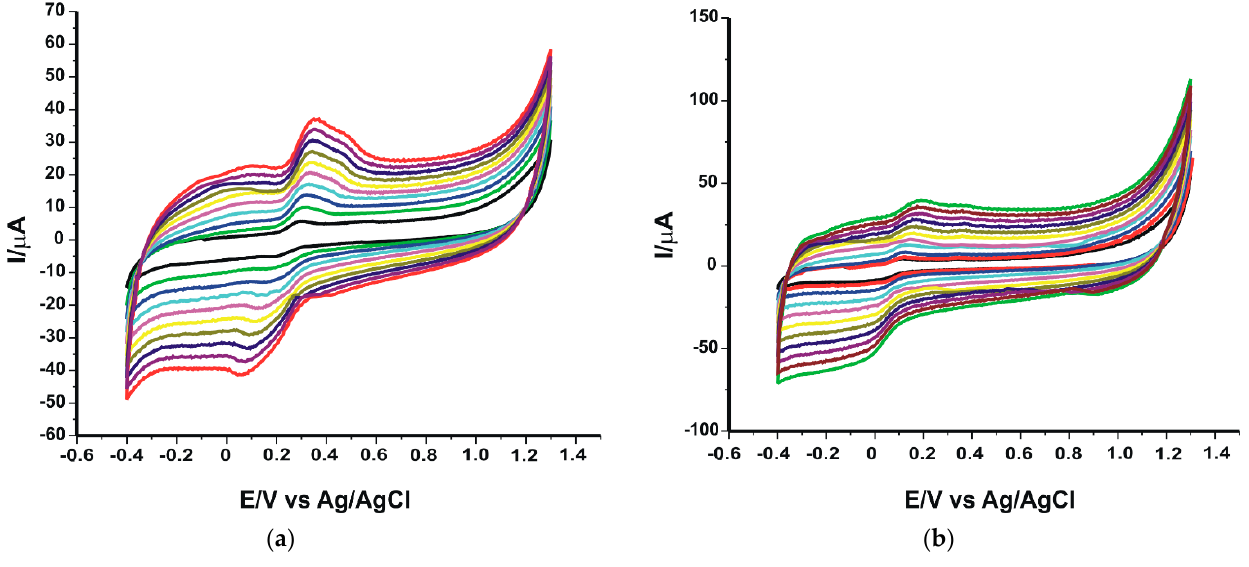
Figure 5. Cyclic voltammograms of SPE/SWCNT/Lac ( a ) and SPE/SWCNT/Tyr ( b ) in 10 − 4 M OLEU–10 − 1 M PBS solution. The cyclic voltammograms with different colours correspond to different scan rates.